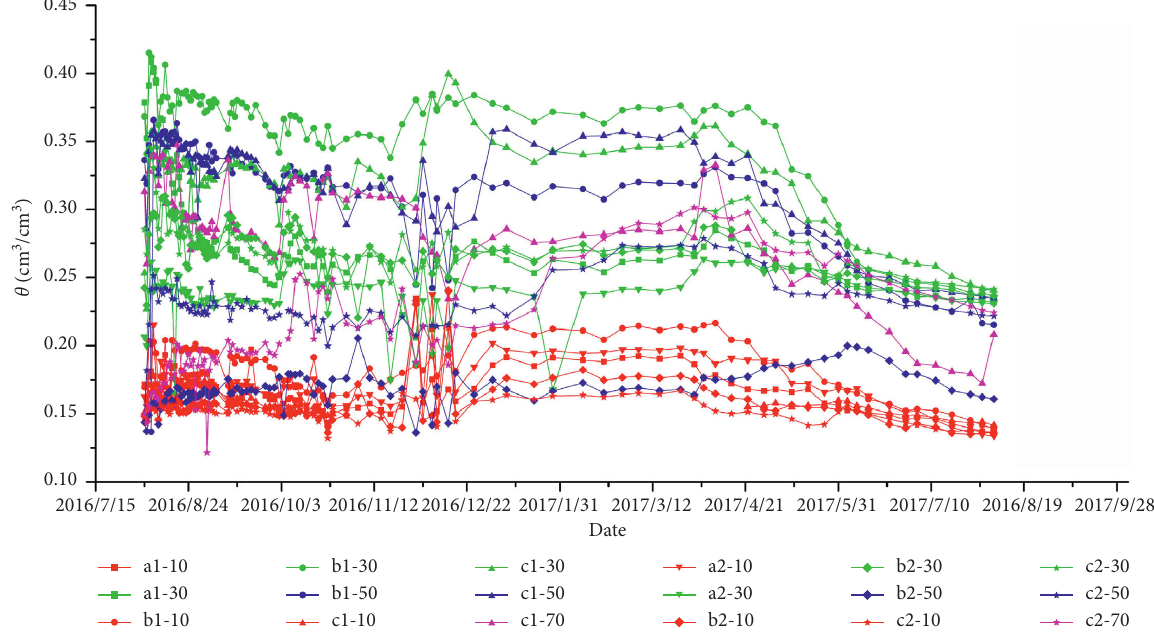
Figure 11: Curves of soil water content varying with time in reconstructed soil at different depths.